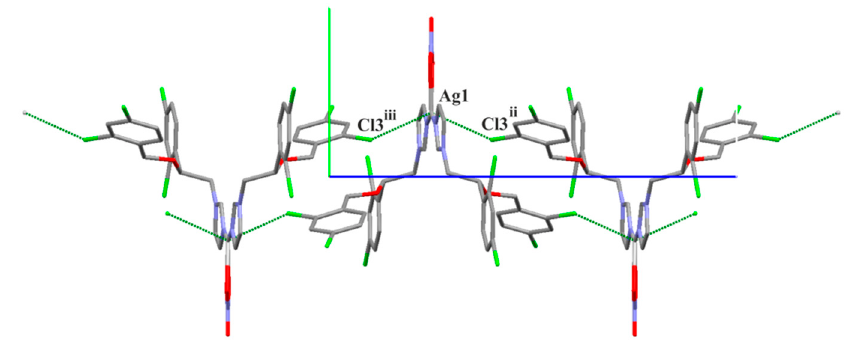
Figure 3. A part of the crystal structure of 1 showing close contacts of Ag ⋯ Cl (green dotted). A view down the crystallographic a axis. Hydrogen atoms are omitted for clarity. Symmetry codes: (ii) 1 − x , − y , 1 − z ; (iii) x , − y , − ½ + z .